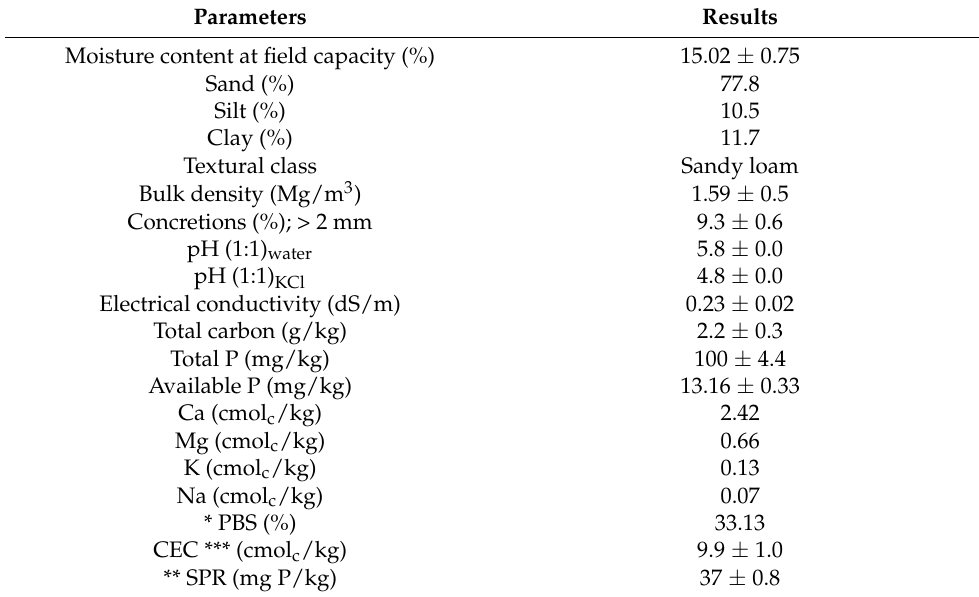
Table 3. Some characteristics of the